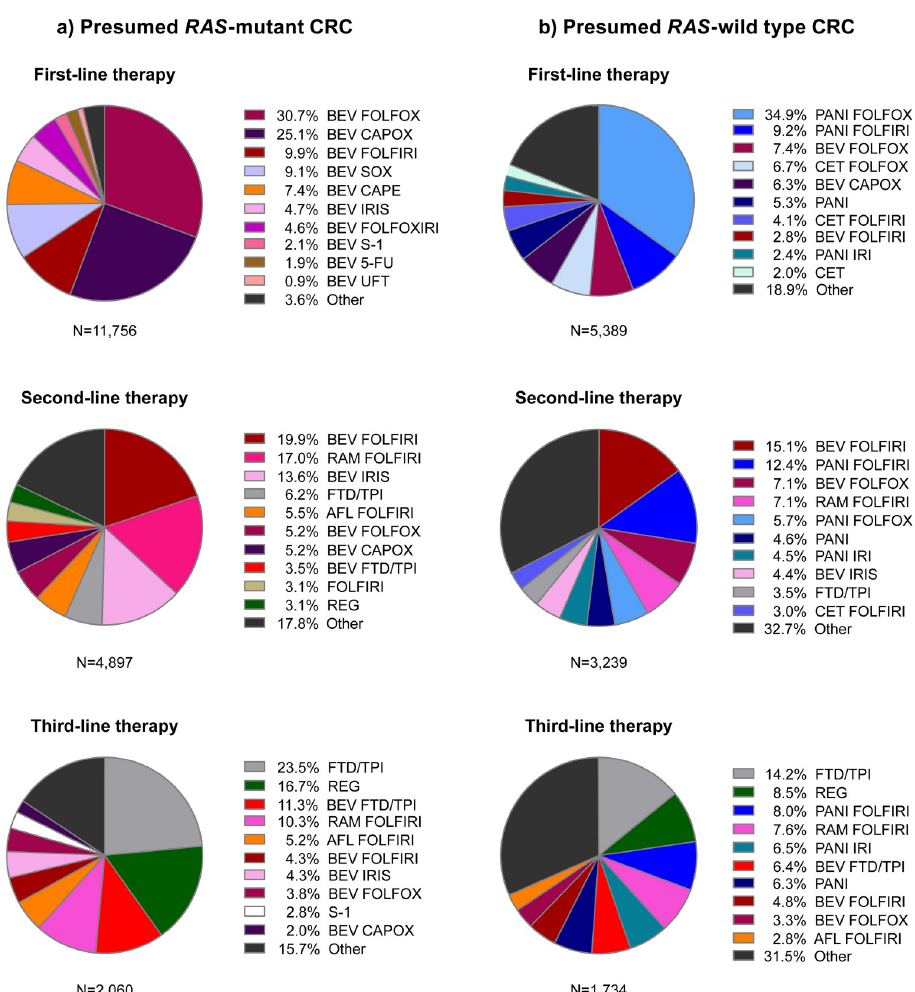
Fig 2. Treatment regimens in the first, second, and third lines for patients in the first-line population (started systemic therapy including biologics without prior evidence of early recurrence) who: a) had no anti-EGFR antibody prescription during the analysis period and were presumed to have RAS- mutant CRC, and b) had an anti-EGFR antibody prescription during the analysis period and were presumed to have RAS -wild type CRC. RAS , rat sarcoma viral oncogene homolog; CRC, colorectal cancer; BEV, bevacizumab; FOLFOX, leucovorin, 5-fluorouracil, and oxaliplatin; CAPOX, capecitabine and oxaliplatin; FOLFIRI, leucovorin, 5-fluorouracil, and irinotecan; SOX, S-1 and oxaliplatin; CAPE, capecitabine; IRIS, S-1 and irinotecan; FOLFOXIRI, leucovorin, 5-fluorouracil, oxaliplatin, and irinotecan; S-1, tegafur/gimestat/potassium otastat; 5-FU, 5-fluorouracil; UFT, uracil and tegafur; RAM, ramucirumab; FTD/TPI, trifluridine/tipiracil; AFL, aflibercept beta; REG, regorafenib; PANI, panitumumab; CET, cetuximab; IRI, irinotecan.